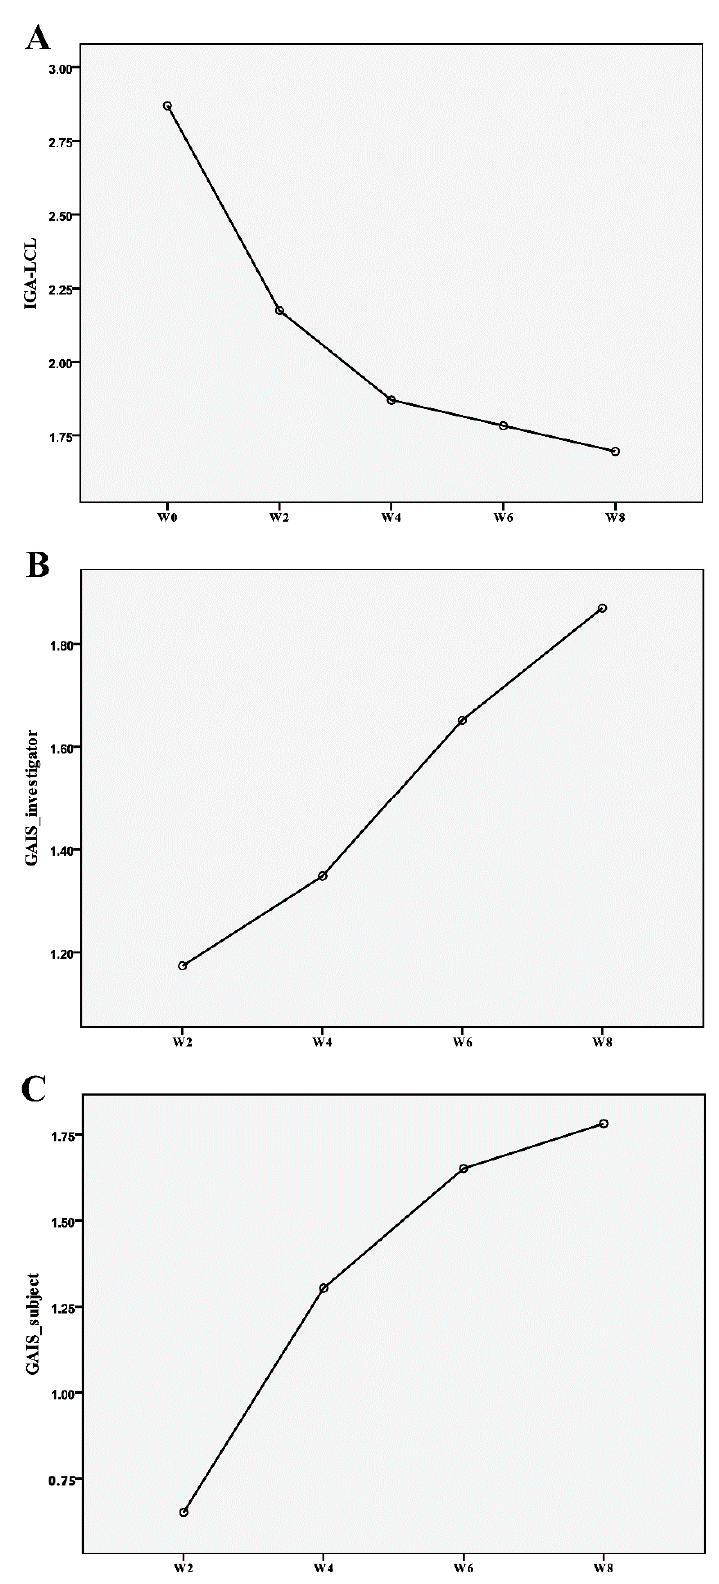
Figure 4. The trends of the ( A ) investigator’s global assessment of the lateral canthal line (IGA-LCL), ( B ) investigator-evaluated, and ( C ) subject-evaluated global esthetic improvement scale (GAIS). The IGA-LCL decreased over time with statistical significance ( p < 0.001), whereas both investigator- evaluated and subject-evaluated GAIS indicated an increase over time with statistical significance ( p = 0.001 and p < 0.001, respectively).